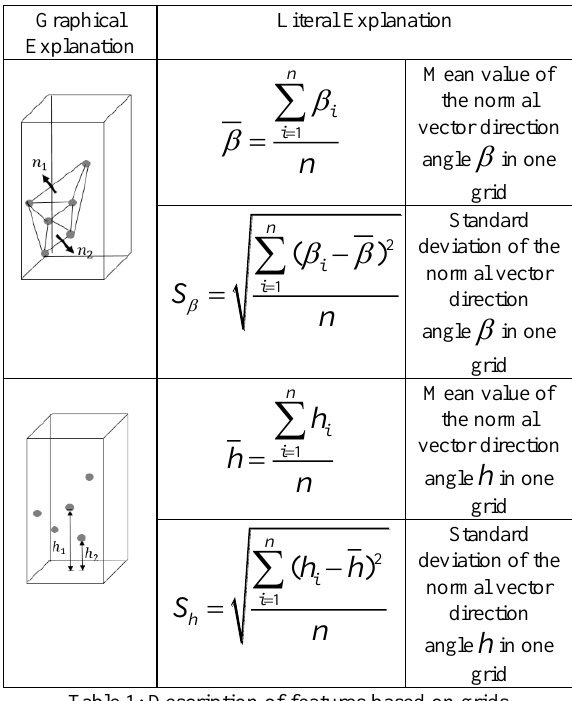
Table 1: Description of features based on